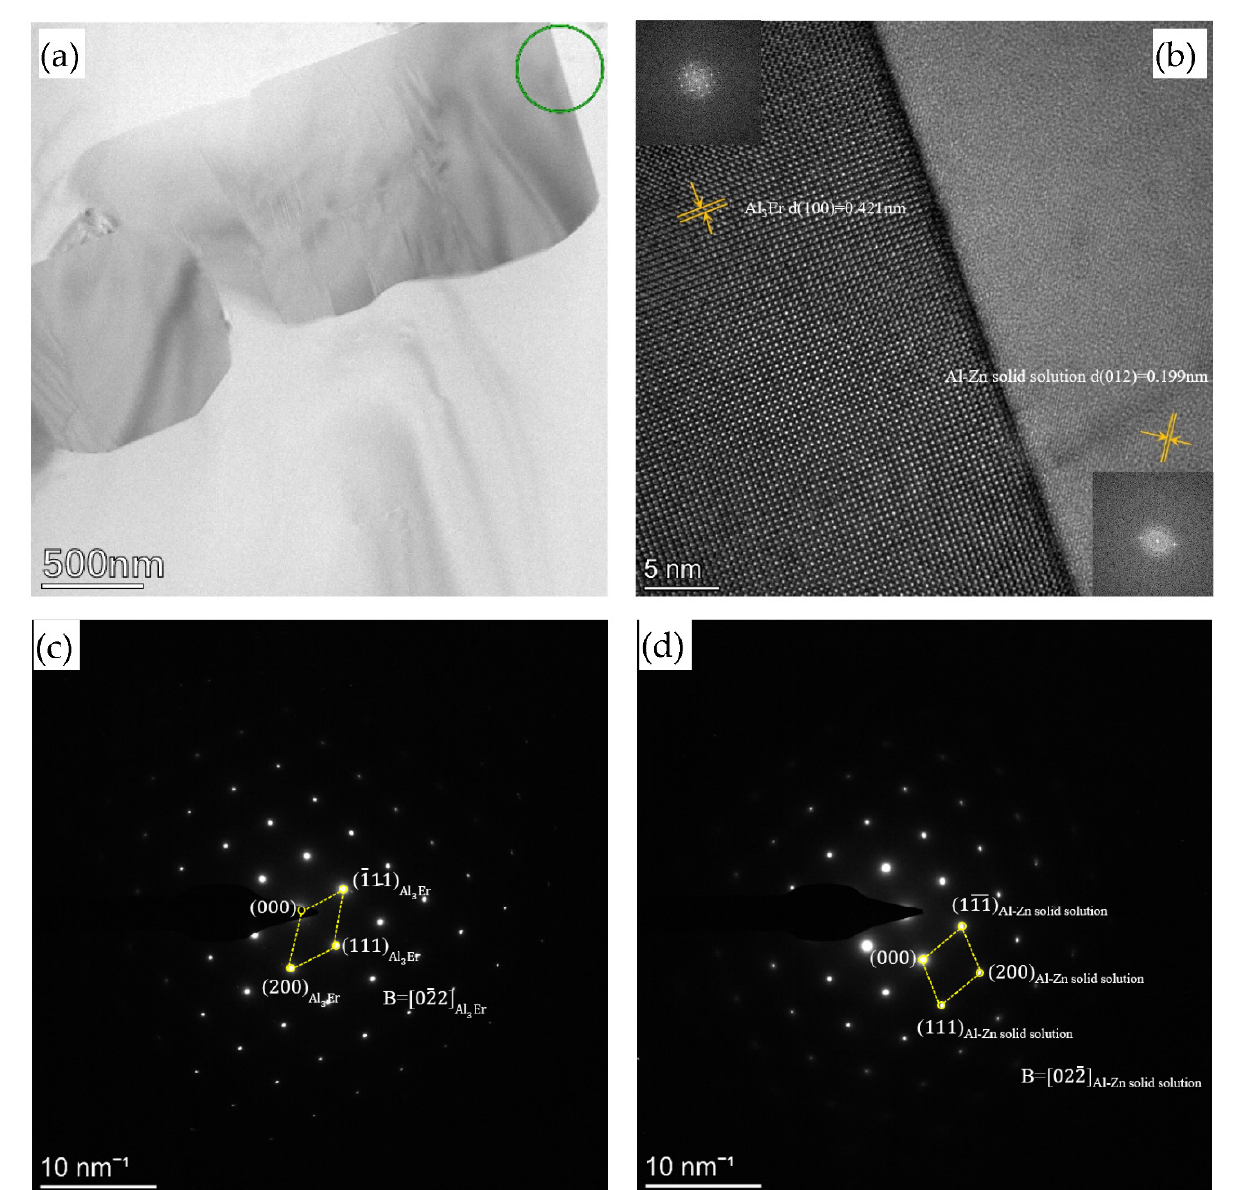
Figure 12. TEM images of the Al-5Zn-0.03In-1Er alloy treated at 615 °C for 32 h: ( a )TEM image, ( b ) HRTEM, ( c ) the SAEDP of the second phase, ( d ) the SAEDP of the alloy matrix.